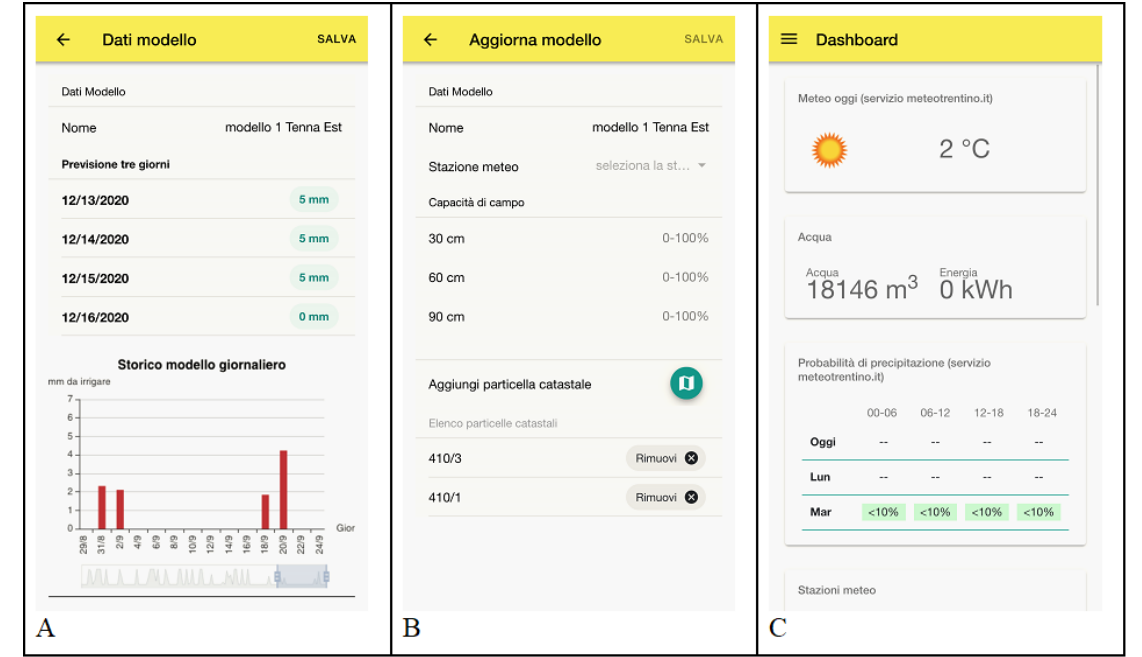
Figure 7. From left: model’s prevision and historical prevision data graph, model terrain settings and parcel association, and app’s dashboard with the seasonal amount of consumed water in m 3 .